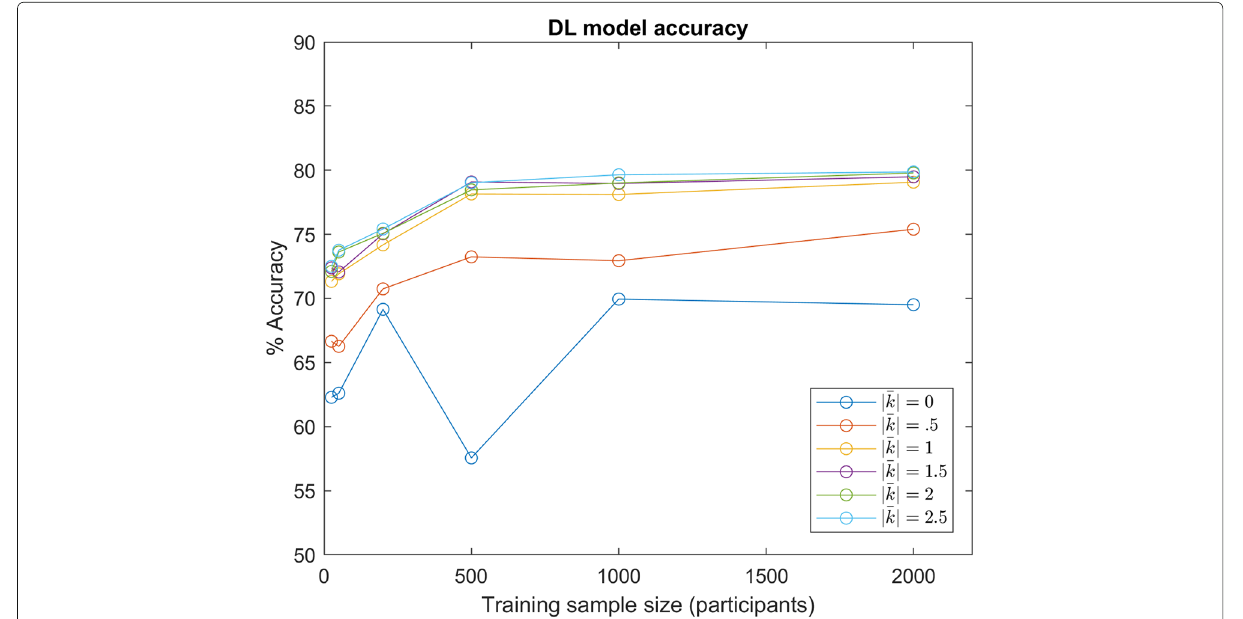
Fig. 13 DL Model Accuracy (Generated): DL model predictive accuracy with different sample sizes and underlying distributions of w , applied to the generalized, abstract data. Various distributions for w are denoted by the approximate average of absolute shape factors k ( Gaussian